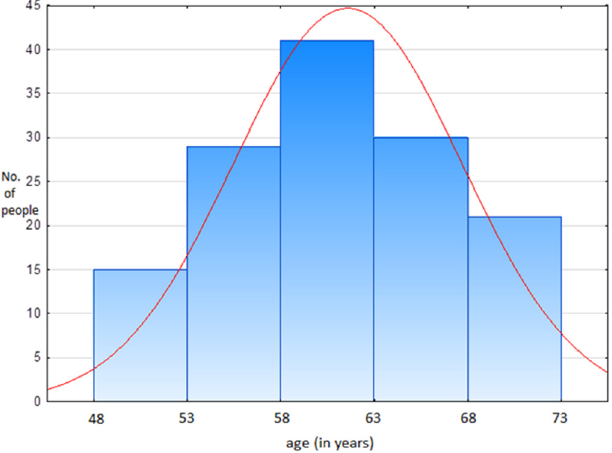
Figure 1. Distribution of patients depending on age ( p = 0.0244) . The red line shows the mean age of of the the patients.